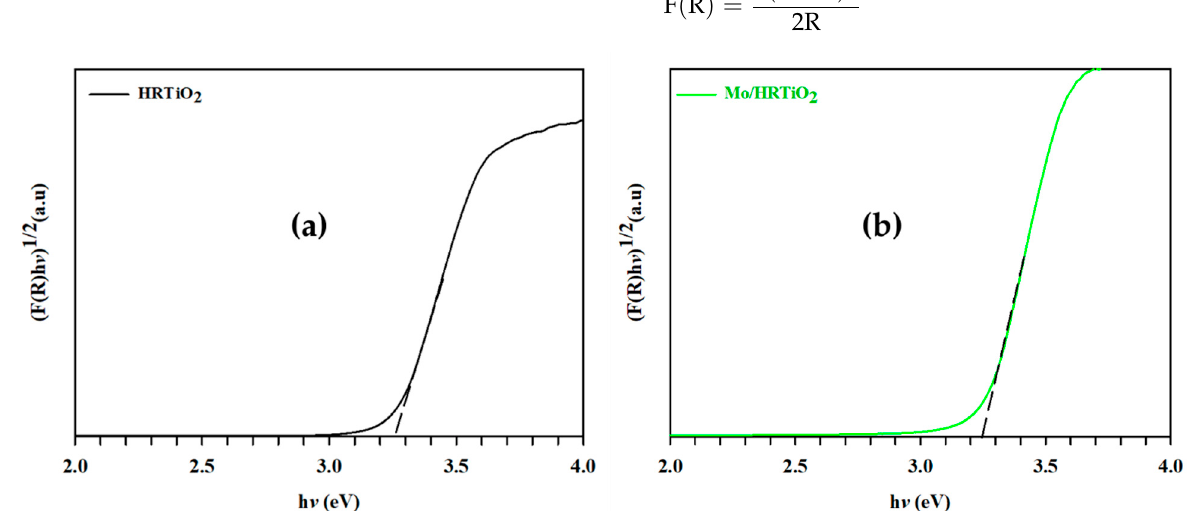
Figure 7. Energy band gap (Eg) estimates for ( a ) unmodified HRTiO 2 , and ( b ) modified Mo/HRTiO 2 .